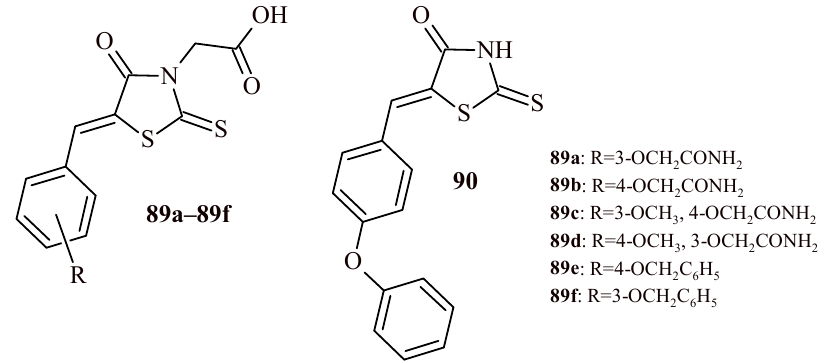
Figure 38. The rhodanine derivatives as α -amylase and α -glucosidase inhibitor. The series of oxazinyl-thiazolidin-4-ones ( 9a – 9f ), in addition to their antioxidant activity (Figure 4), showed inhibitory activity towards α -amylase and α -glucosidase en- zymes in the range of IC 50 values of 4.08–53.68 µ g/mL and 1.01–39.12 µ g/mL, respectively [22]. The Compounds 9a and 9b revealed inhibition of α -amylase at concentration 9.31 and 4.08 µ g/mL. These activities were better than activity of reference drug acarbose (IC 50 = 11.56 µ g/mL). Additionally, these compounds ( 9a and 9b ), as well as Compound 9e, showed inhibitory effects against α -glucosidase enzyme with IC 50 values of 1.01, 6.14 and 9.24 µ g/mL, respectively. These values also were more beneficial in comparison to acarbose (IC 50 = 17.23 µ g/mL). Bilgicli et al. reported, that the piperonyl-based thiazolidine-4-one derivative, namely: 3-(benzo[ d ][1,3]dioxol-5-ylmethyl)-2-(4-nitrophenyl)thiazolidine-4-one, showed very po- tent inhibition of α -glucosidase at nanomolar concentration (IC 50 = 5.9 nM) (Figure 39)